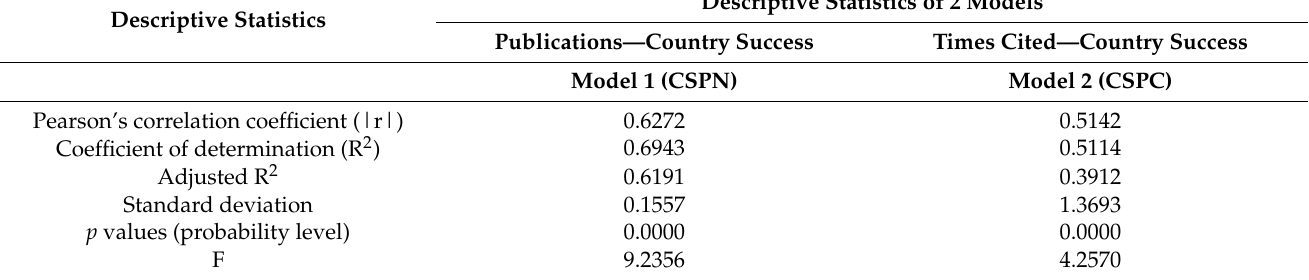
Table 6. Descriptive statistics for two models.